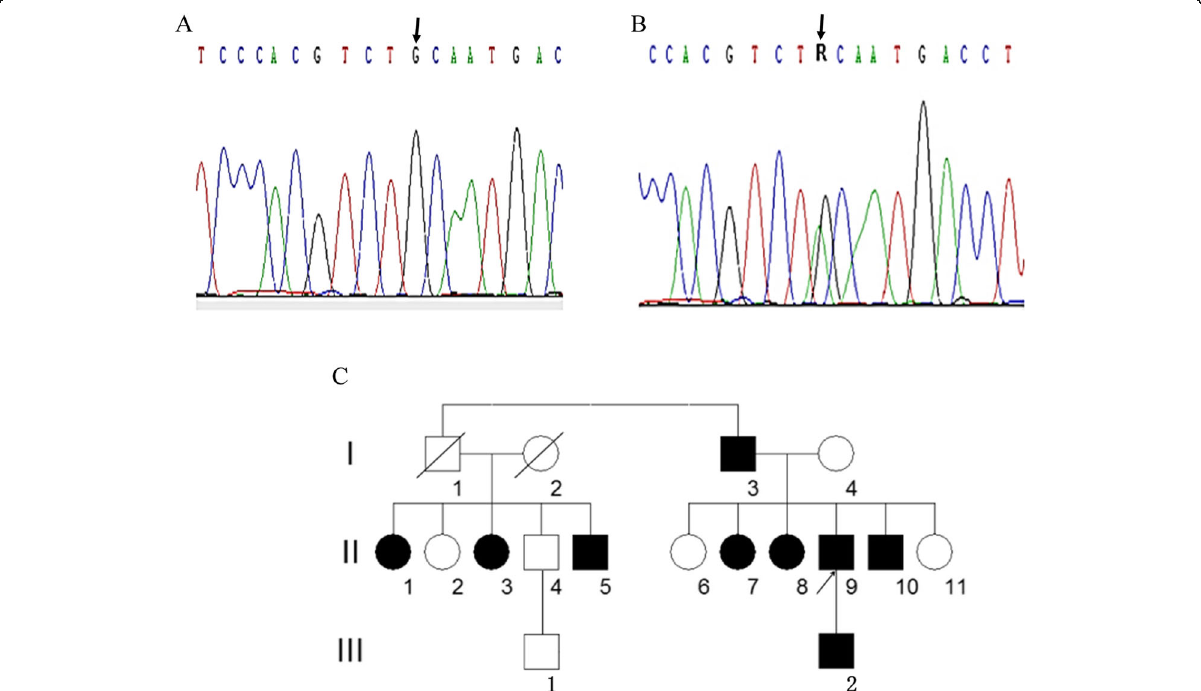
Fig. 1 DNA sequencing results and the pedigree chart. Shown here are the wild-type (panel a ) and the C308Y mutation (panel b ) DNA sequencing histograms. The nucleotide G at position 923 of exon 7 in the wildtype (arrow in panel a ) was mutated to the nucleotide A (arrow in panel b ) in the heterozygote. According to the DNA sequencing results, a pedigree chart was established (panel c ). Unfilled squares are healthy males and filled squares are mutant males; unfilled circles indicate healthy females and filled circles mutant females. A cross line denotes a deceased individual and the arrow indicates proband